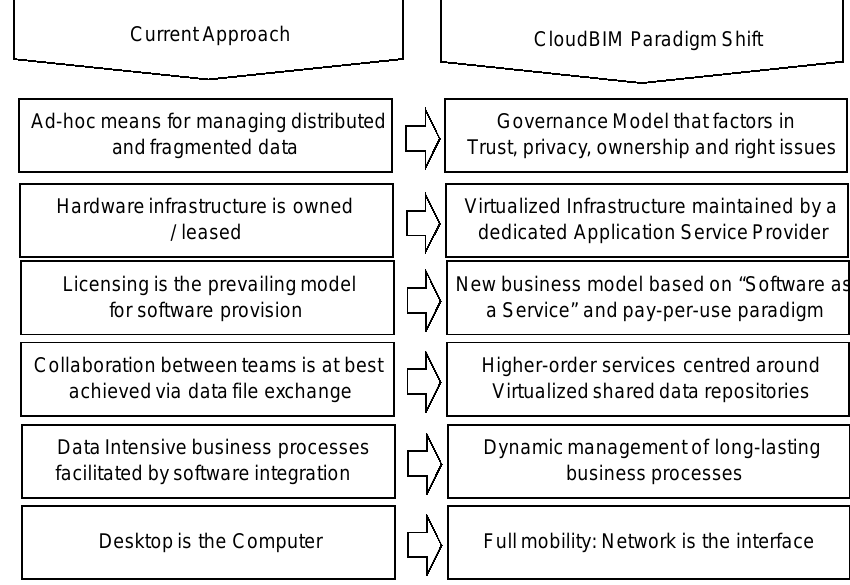
Fig. 14. Paradigm